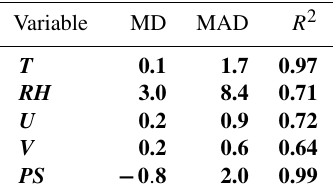
Table 4. Same as Table 3 but for daily mean variables in WRF_NUDGE